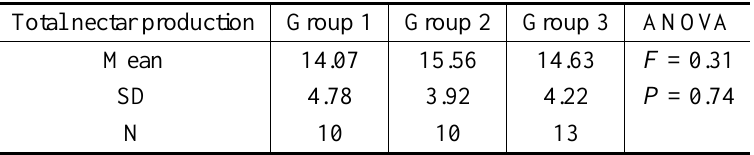
Effect of nectar removal on total nectar production in Palicourea crocea in the Upper Paraná River floodplain. Flowers were subject to six (Group 1), three (Group 2) or one (Group 3; control) removals of nectar at regular intervals between 0800h and 1800h. SD: standard deviation. Means were compared using one-way